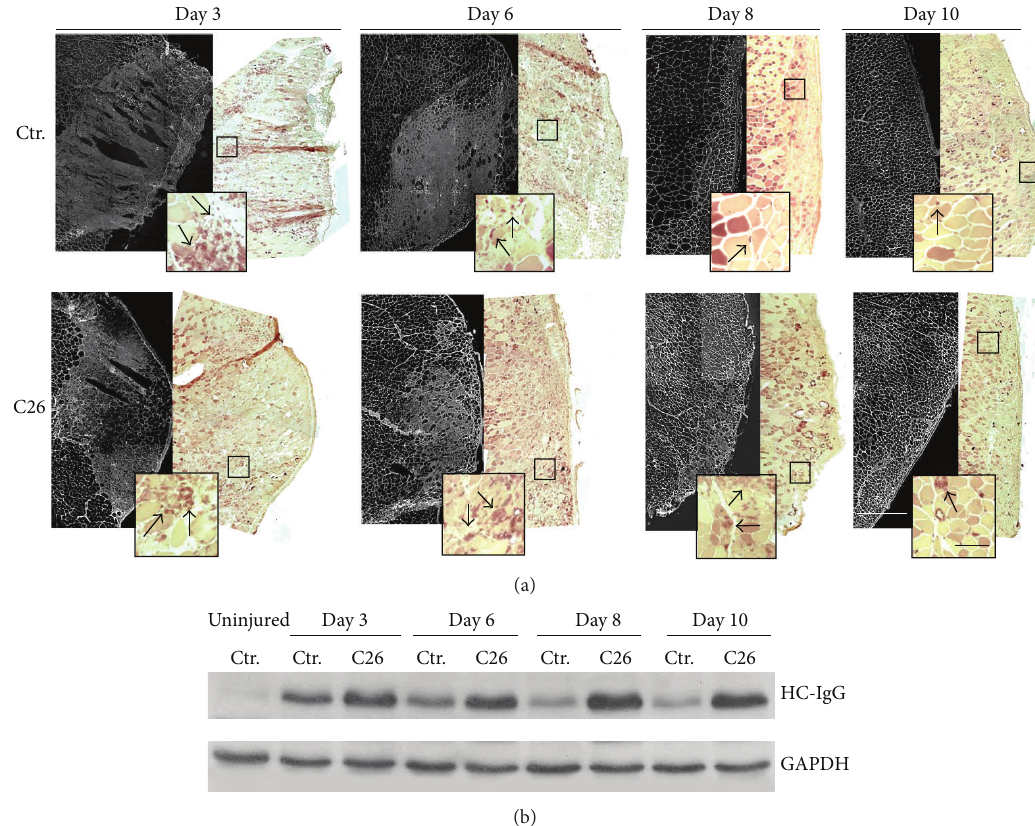
Figure 2: C26-bearing mice show a prolonged inflammation response during muscle regeneration. (a) Left panels: immunofluorescence analysis of IgG expression performed at the lesion site of reconstructed areas of tibialis muscles from both control and C26-bearing mice. (a) Right panels: esterase staining uptake at the same lesion sites highlighting the presence of macrophages in the inflamed muscles. Insects depict magnification of areas defined in the squares. Black arrows show macrophages. White bar = 0.5 mm; black bar = 100 𝜇 m. (b) WB analysis of IgG expression on extracts from muscles shown in (a). First lane was loaded with the extract from a healthy, uninjured control muscle. GAPDH was used as loading control.